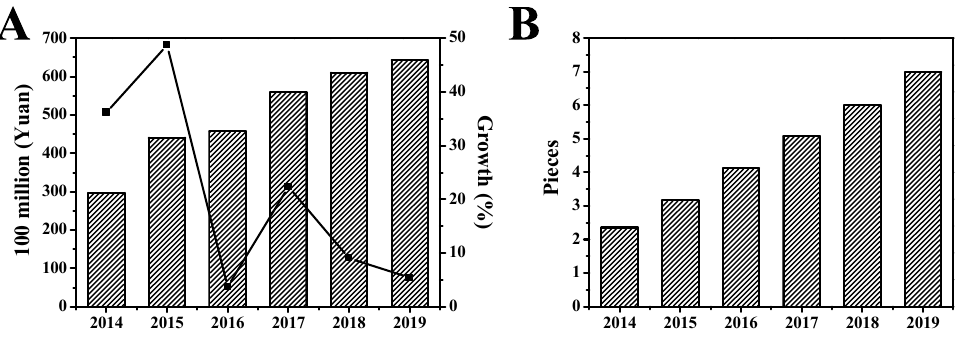
Figure 8. ( A , B ) The development trend of the Chinese film and television Figure 8. ( A-B ) The development trend of the Chinese film and television industry.